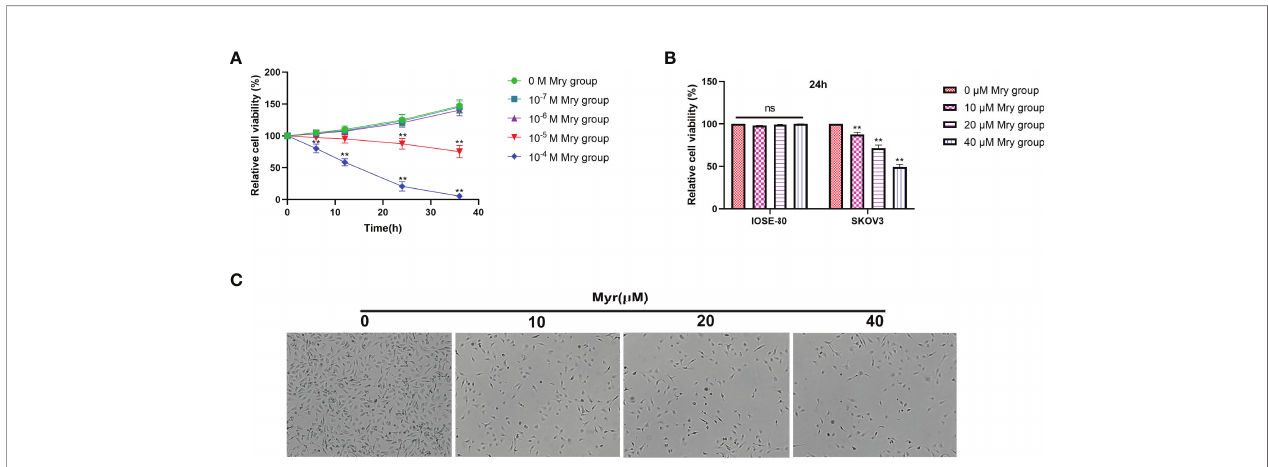
FIGURE 1 | Effects of different concentrations of myricetin on cell cytotoxicity/viability. Determination of cell viability using CCK-8 assay and Myr cytotoxicity at 0, 10, 20 and 40 m M. (A) The effect of Myr on the viability of SKOV3 cells at different doses and times were determined by CCK-8 analysis. (B) Cytotoxic effect of different Myr concentrations on IOSE-80 cells and SKOV3 cells was determined by CCK-8 analysis. (C) SKOV3 cells were incubated with 0, 10, 20 and 40 m M Myr for 24 h. Representative microscopic images are shown (×40 magni fi cation). n = 3, ** p <0.01 vs.